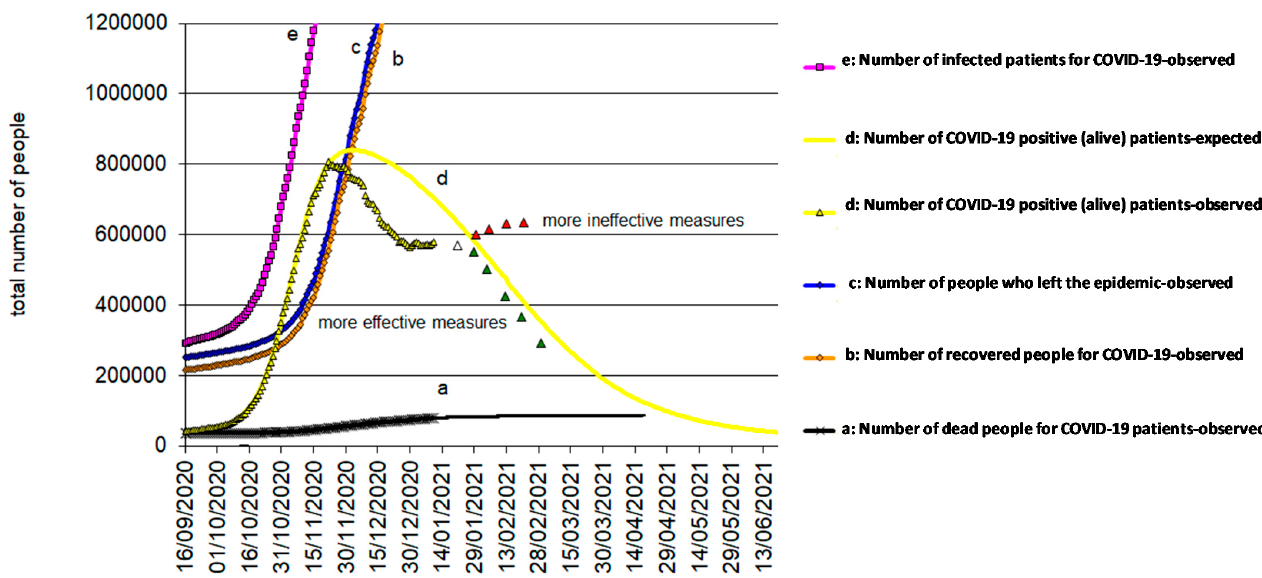
Figure 7. COVID-19 epidemic time-course in UK during the second wave, in detail, and incidence of this disease with effective and ineffective measures.